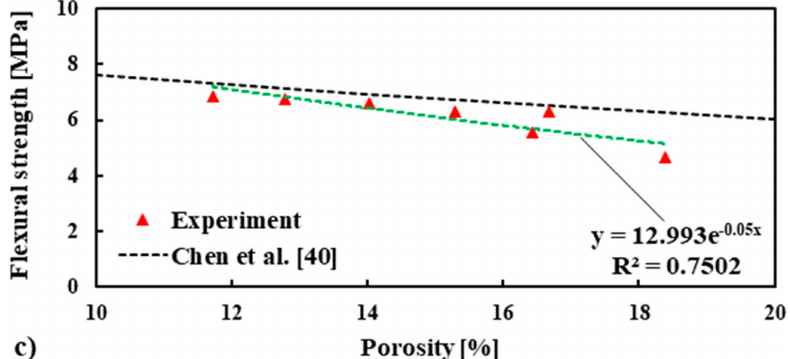
Figure 9. The relations of apparent porosity with compressive ( a ), tensile ( b ), and flexural strength ( c ), respectively, are compared with di ff erent models / exponential relationships available in the